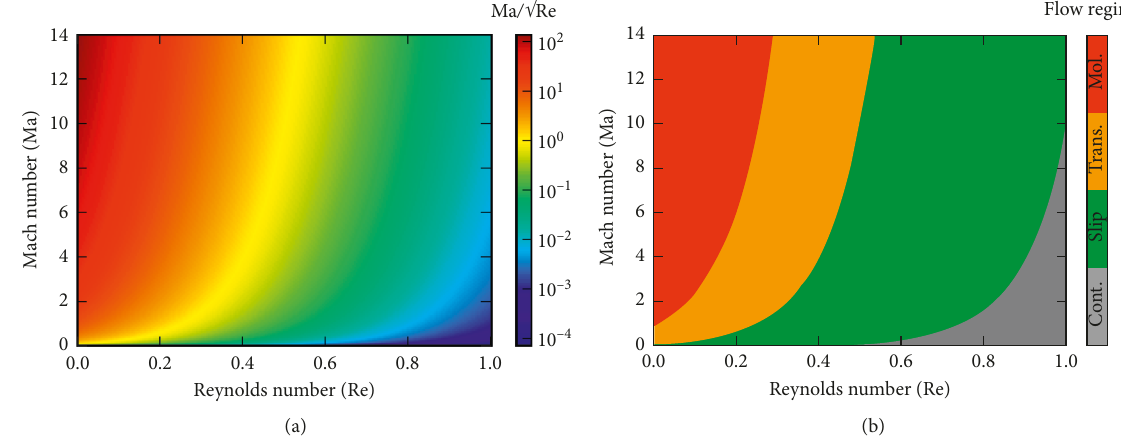
��� √ Figure 2: (a) Variation of Ma/ Re values as a function of Re and Ma, and (b) graphical representation of corresponding gas flow regimes. Here, Cont., Slip, Trans., and Mol. represent continuum flow regime, slip flow regime, transition flow regime, and molecular flow regime, respectively.